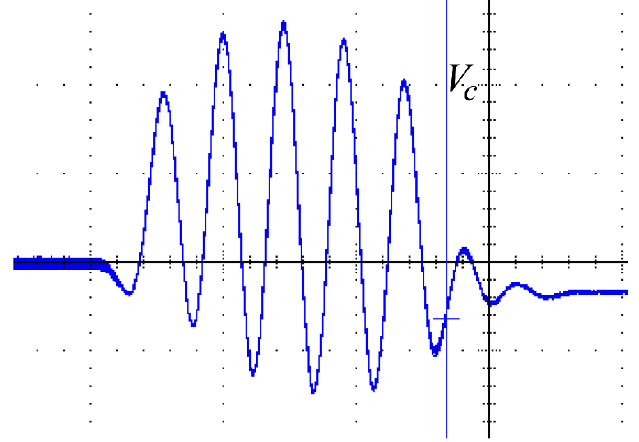
Figure 15. Experimental voltage waveforms of the Class-D resonant converter (200 nS/div 20 V/div). VPP = 83.6 V.